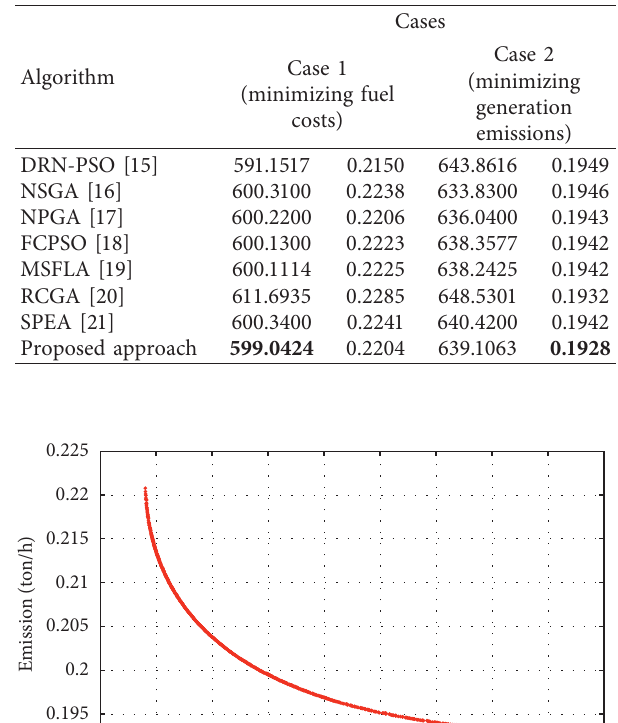
Table 4: Optimal solutions by different methods: case 1 and case 2.